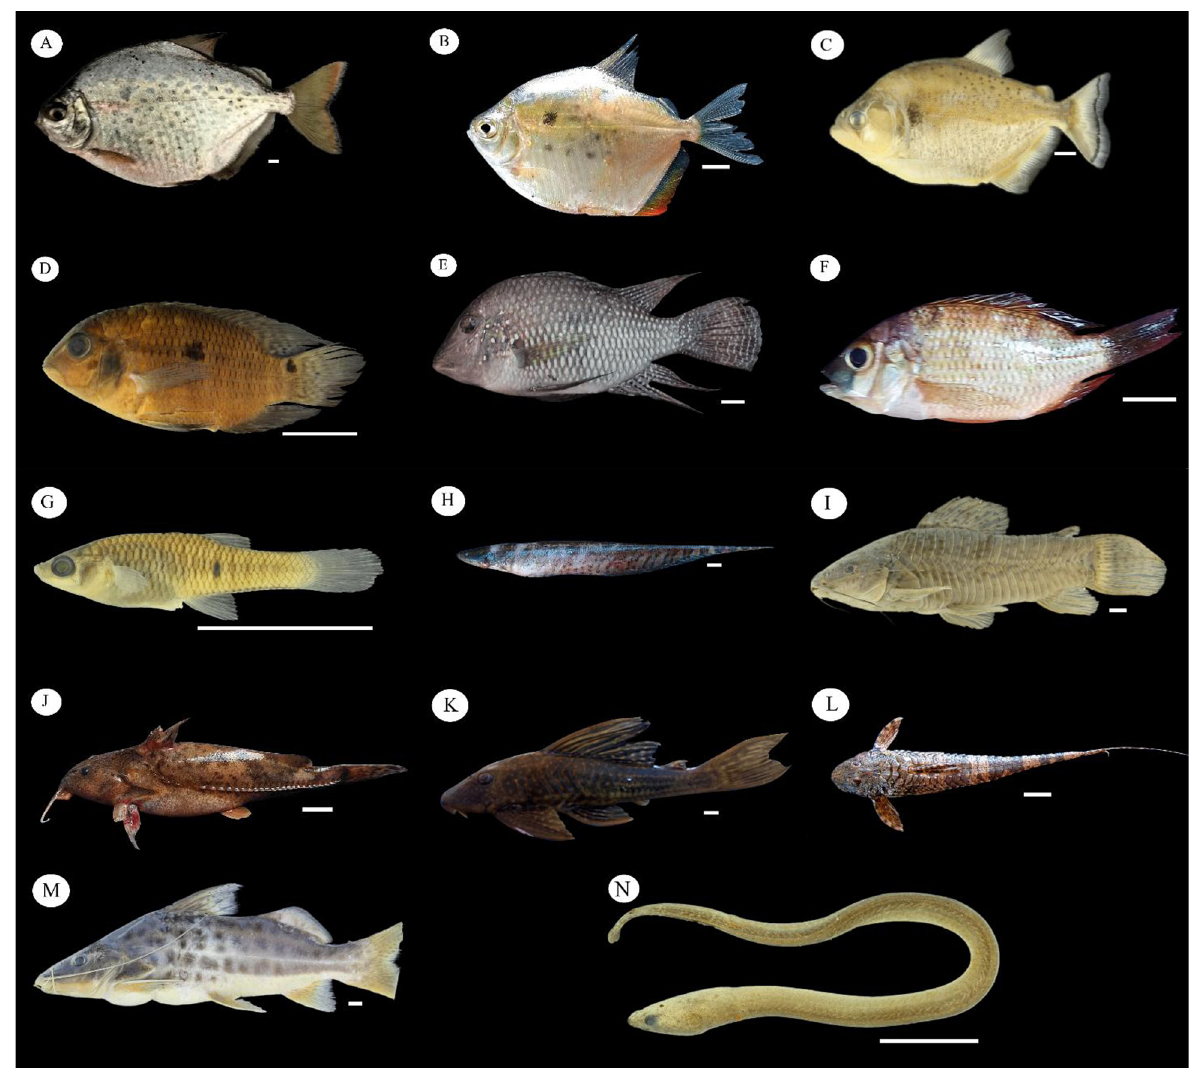
Figure 6. Representative samples of fish species collected in Rio Santa Bárbara, Sapucaí-Mirim/Grande hydrographic basin, São Paulo state, Brazil. A. Metynnis maculatus , LIRP 15735, 103.00 mm SL. B. Metynnis mola , LIRP 15786, 15.00 mm SL. C. Serrasalmus maculatus , LIRP 15788, 15.50 mm SL. D. Cichlasoma paranaense , LIRP 15732, 43.60 mm SL. E. Geophagus cf. brasiliensis , LIRP 15759, 138.19 mm SL. F. Oreochromis niloticus , LIRP 15789, 65.00 mm SL. G. Phalloceros harpagos , LIRP 15728, 19.93 mm SL. H. Gymnotus carapo , LIRP 15745, 240.00 mm SL. I. Callichthys callichthys , LIRP 15727, 146.03 mm SL. J. Rhinodoras dorbignyi , LIRP 15716, 111.30 mm SL. K. Hypostomus sp., LIRP 15789, 240.00 mm SL. L. Rineloricaria latirostris , LIRP 15715, 140.00 mm SL . M. Pimelodus maculatus , LIRP 15764, 230.00 mm SL. N. Synbranchus marmoratus , LIRP 15777, 72.15 mm SL. Scale bars = 1 Cichlasoma paranaense Kullander, 1983 Figure 6D Geographic distribution . Rio Paraná basin. Materials examined. Vouchered materials: LIRP 15732, 15736, 15739, 15770, 15776, 15782, and 15783; Sampling sites B, C and D of Table 1. Non‑vouchered materials: Sampling sites A and E of Table 1. Identification. Mouth terminal; premaxilla with 2 or 3 teeth rows, and dentary with 3 or 4 teeth rows. Upper lateral line with 14–17 pored scales, lower lateral line with 5–8 pored scales. Dorsal fin with 13–15, 10–15 and anal fin with 3, 8–10 rays. Ground color iridescent green, with dark‑brown transverse bars, a dark‑brown rounded blotch slightly below upper lateral line, and a dark‑brown blotch on superior portion of caudal peduncle.